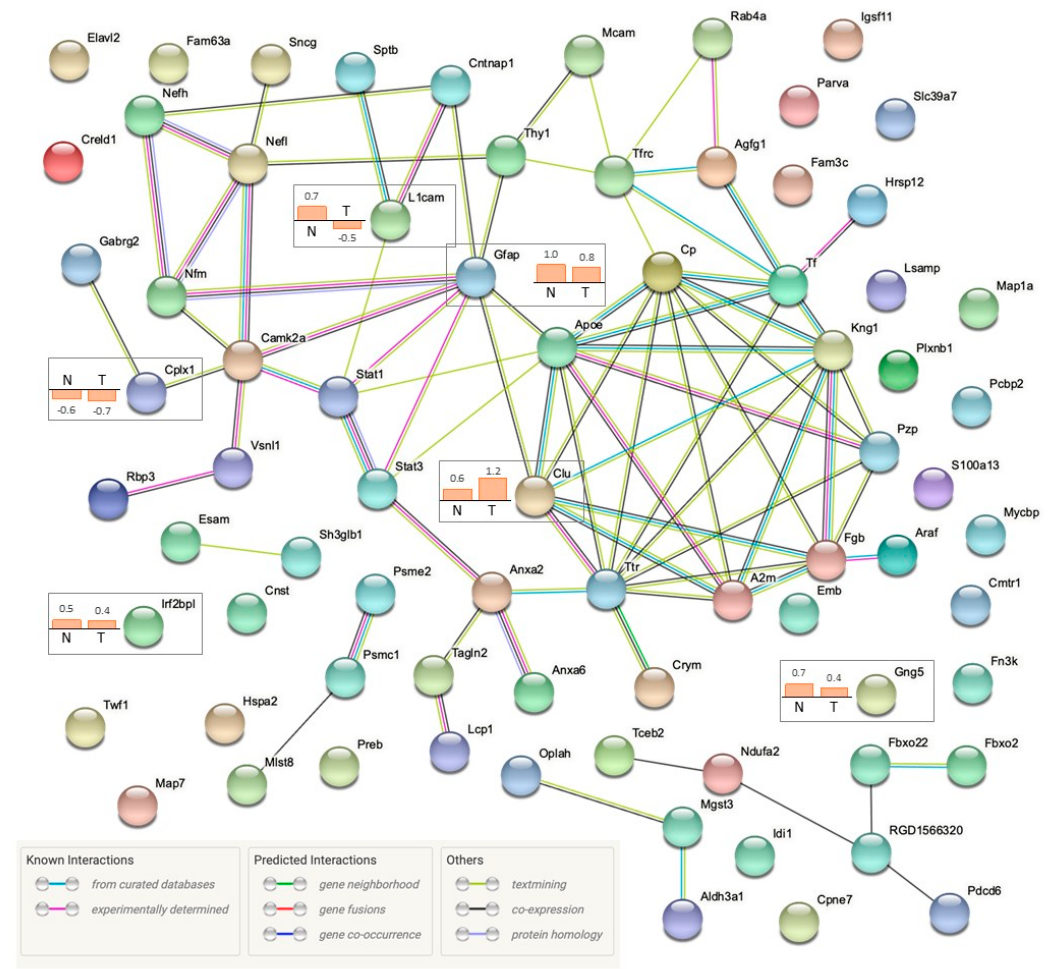
Figure 6. Protein–protein interaction analysis of regulated proteins two weeks after pONT with STRING database (STRING, version 11.0). A total of 80 non-redundant, significantly differentiated proteins from the nasal or temporal quadrants were converted to 75 matched gene IDs from UniProt accession numbers using the Uniprot database. Protein–protein interaction network was executed with “ Rattus norvegicus ” as the selected organism. Shared proteins ( n = 6) are highlighted with their fold change (log2) determined by SWATH-MS. Table 4. Bioinformatic analysis using SWATH-based proteomic data obtained from temporal (T) and nasal (N) retinal